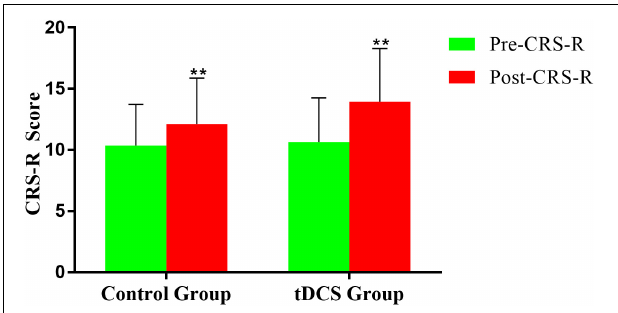
FIGURE 4 | Comparison of CRS-R improvement between the two groups before and after treatment. * p <